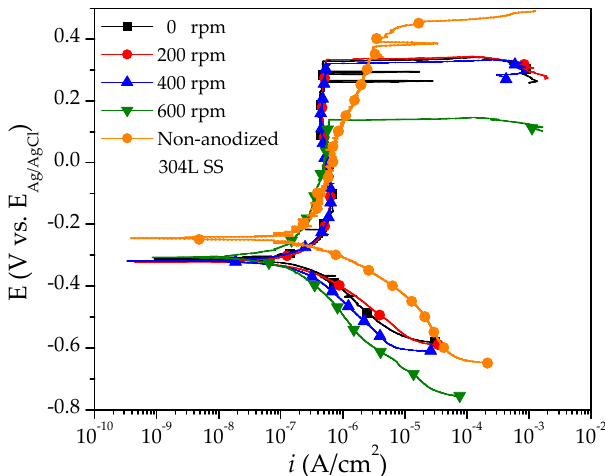
Figure 2. Potentiodynamic polarization curves of the samples anodized for 15 min, at different stirring speeds.